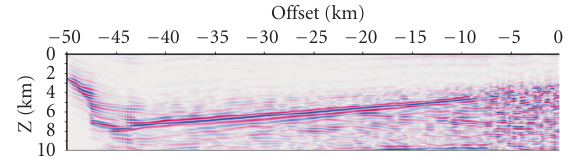
Figure 8: PSDM imaging result using selected crosscorrelation traces by stationary phase evaluation. This result much improves compared with Figure